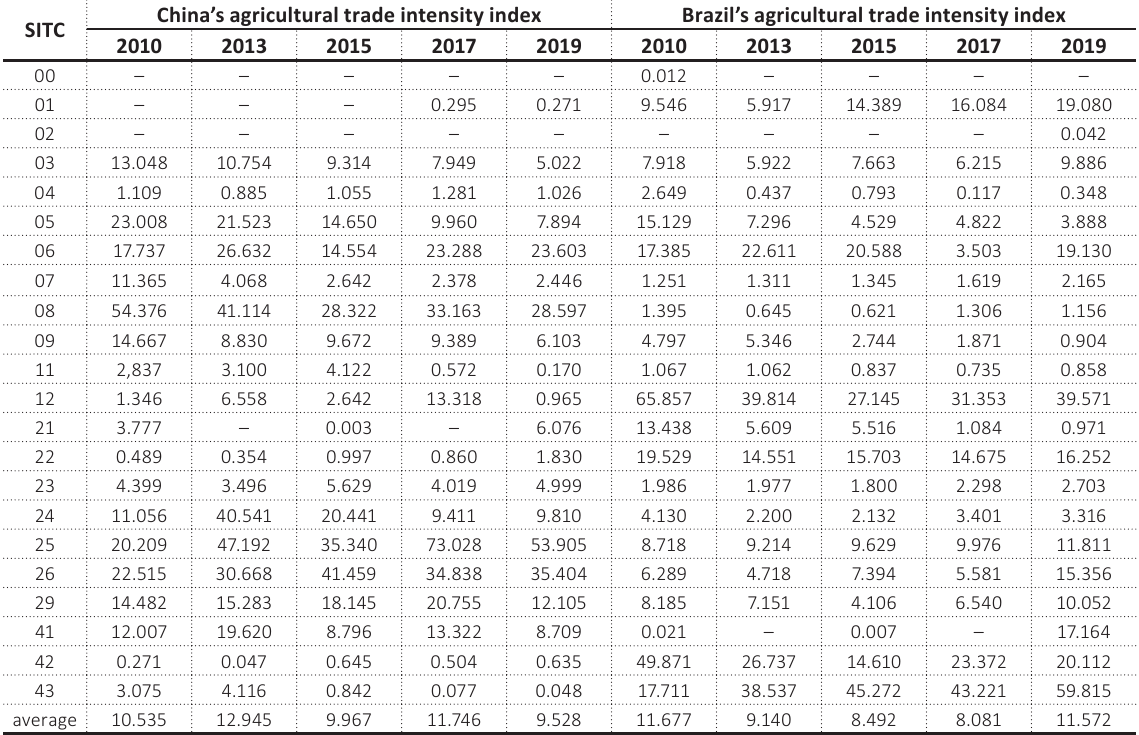
Table 6. China and Brazil’s agricultural trade intensity index